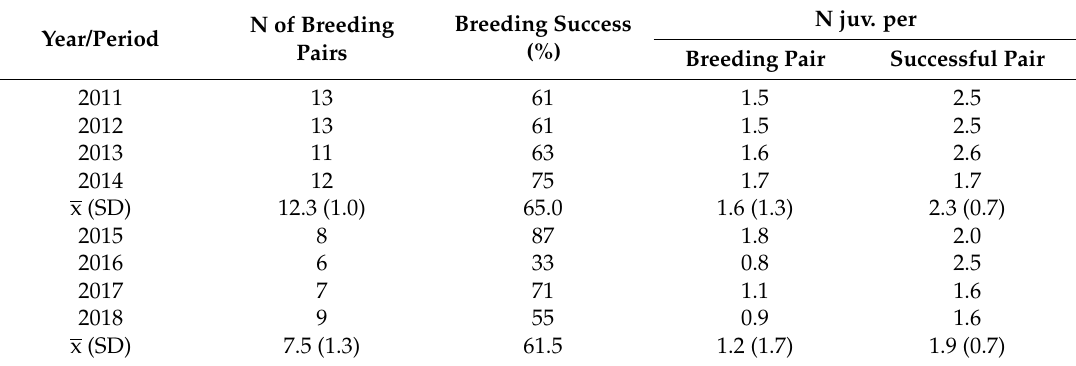
Table 1. Breeding parameters of the raven population in Central Poland in the ‘pre ASF’ (2011–2014) and ‘ASF outbreak’ (2015–2018) periods.